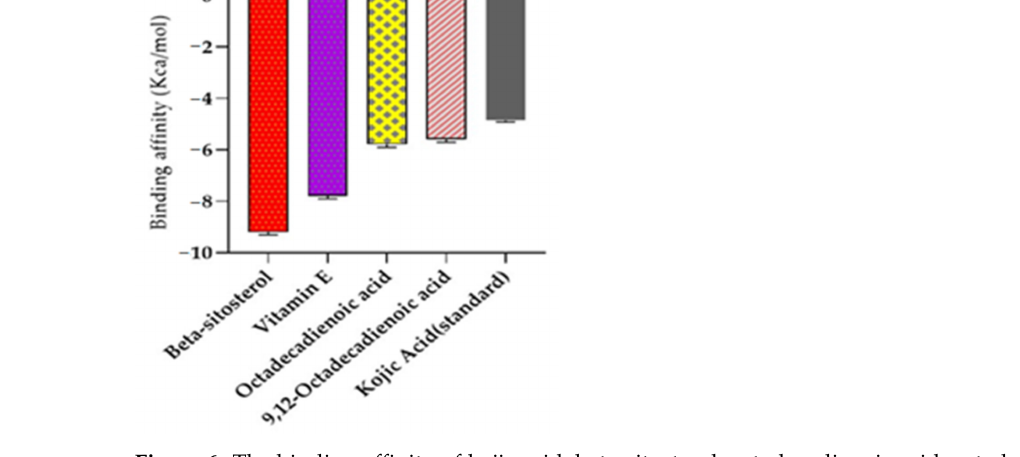
Figure 6. The binding affinity of kojic acid, beta-sitosterol, octadecadienoic acid, octadecatrienoic acid methyl ester, and vitamin E with tyrosinase enzyme.